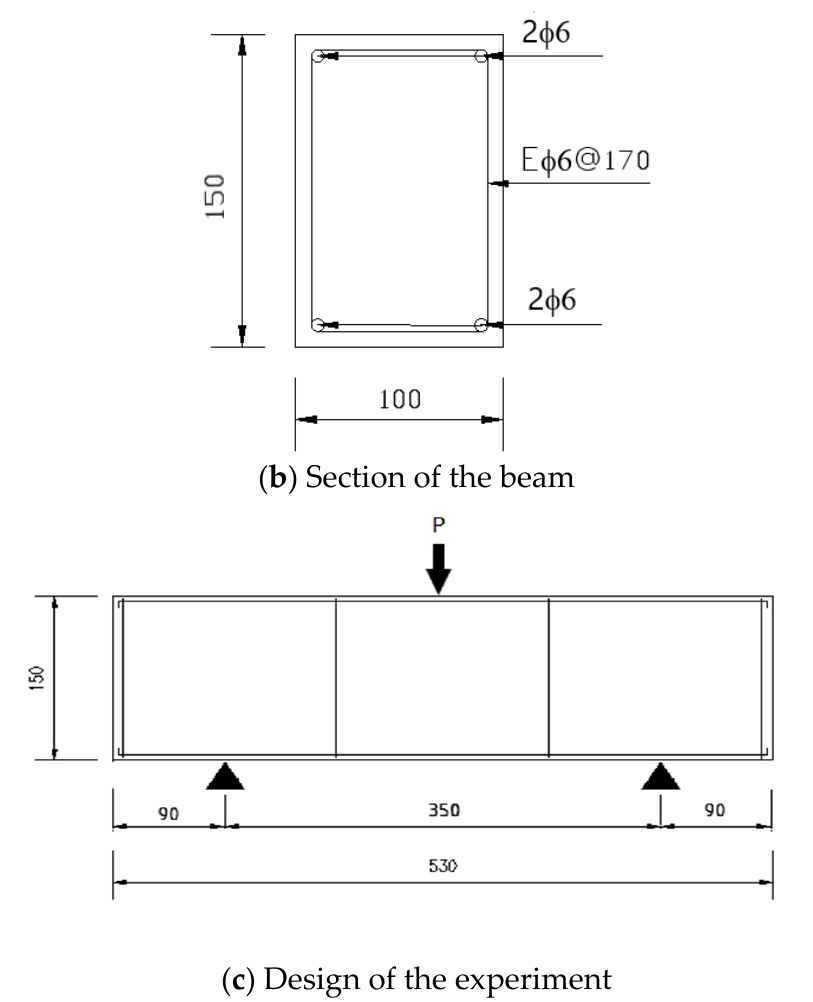
Figure 2. Diagram of the beams tested and the experiment layout.